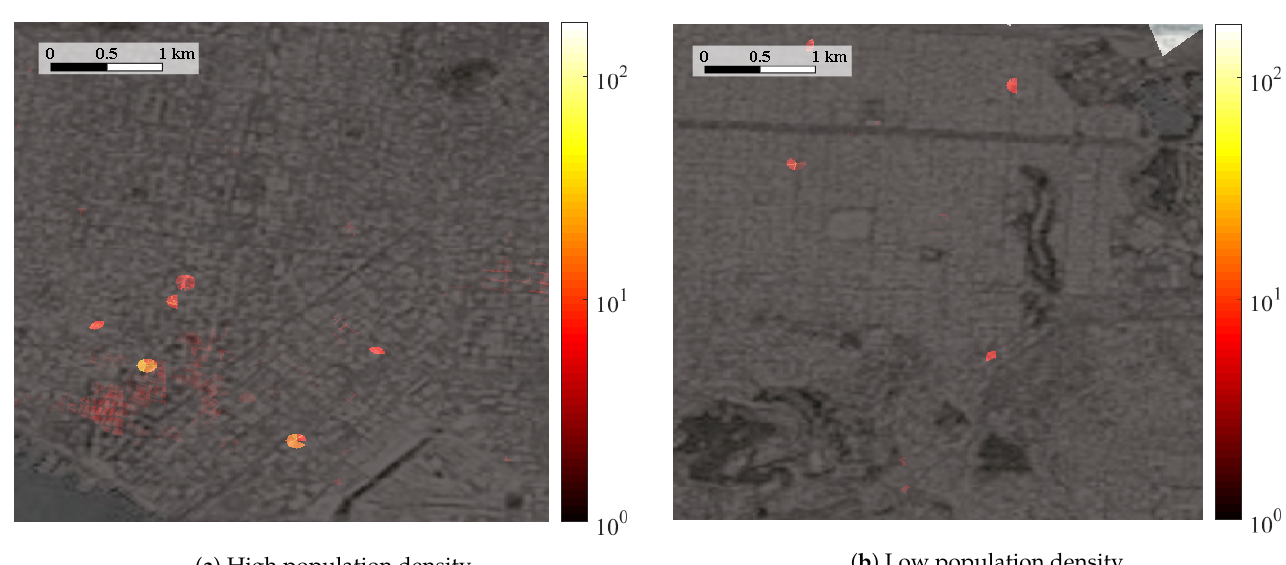
Figure 7. Results of M UE with the Context model in the sections presented in Figure